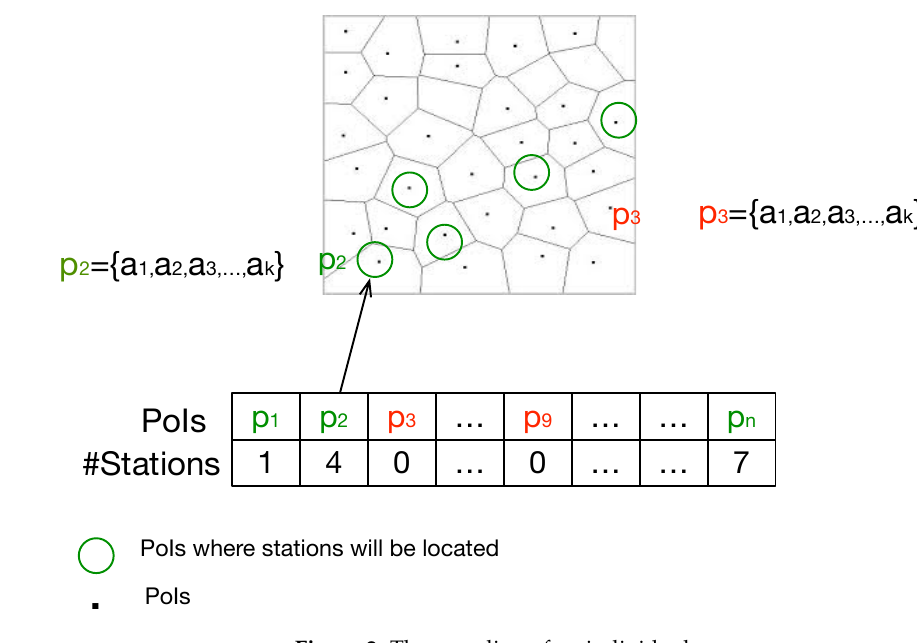
Figure 2. The encoding of an